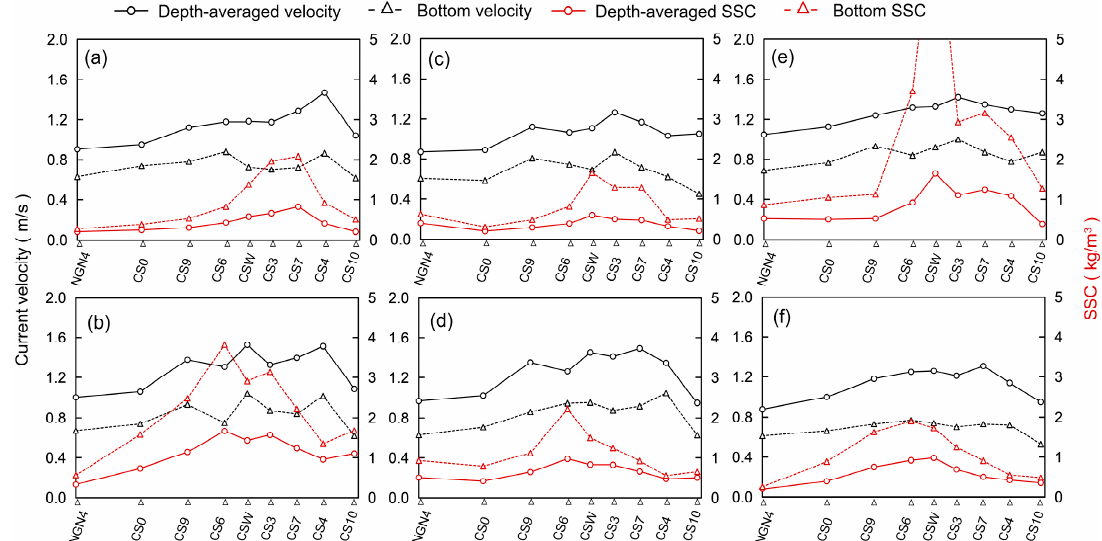
Figure 8. Along-channel distributions of tidal-averaged bottom current velocity, SSC and depth-averaged current velocity, SSC: The ( a – f ) represent six observations respectively (according to Figure 2). The averaged current velocity magnitudes in the figure were calculated by absolute values of current velocities over two flood-ebb tidal cycle and denote the strength of tidal dynamic.